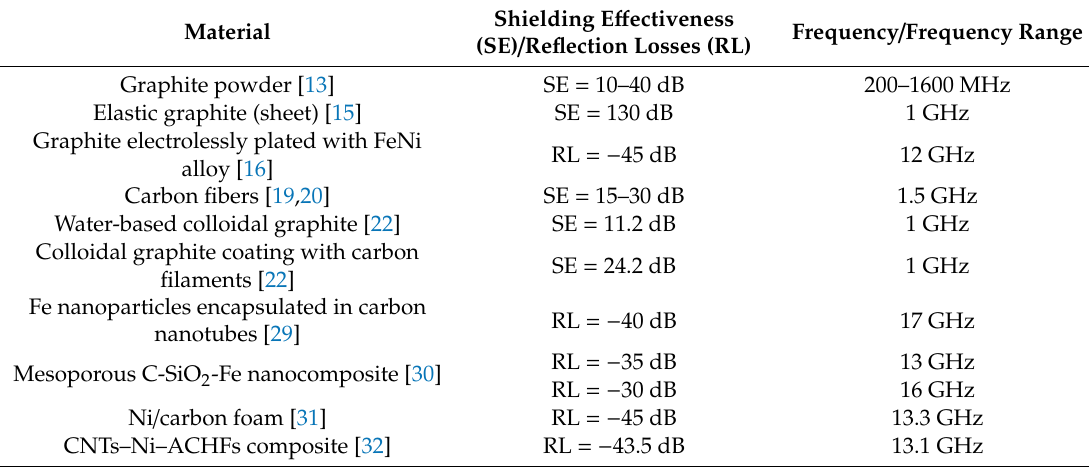
Table 3. Shielding e ff ectiveness or reflection losses of carbon-based